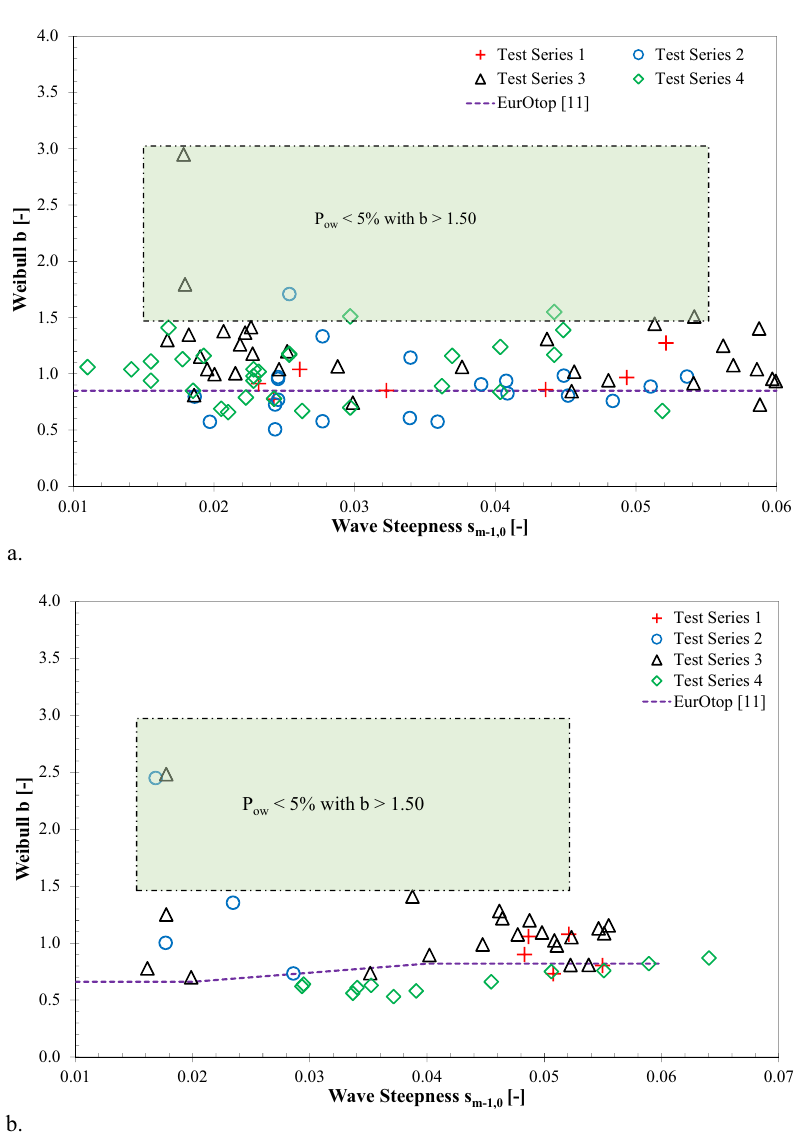
Figure 5. Influence of incident wave steepness on Weibull b parameters: (a) impulsive wave conditions,and (b) non-impulsive wave